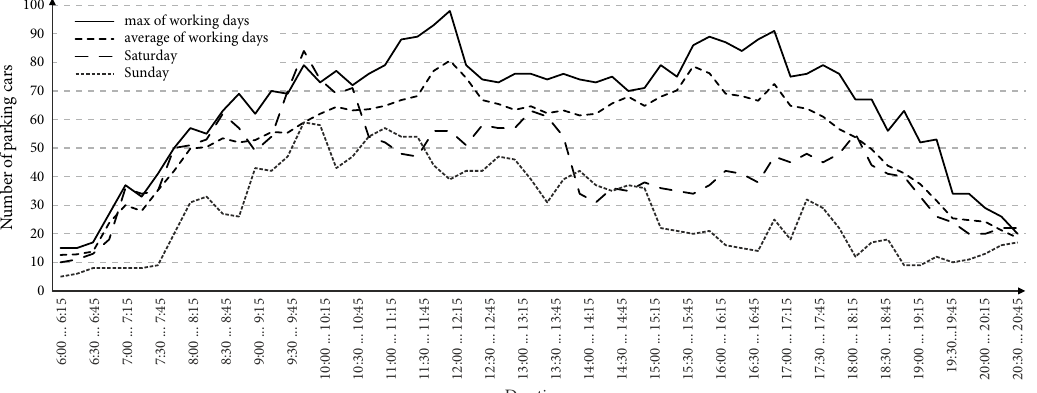
Figure 3. Numbers of occupied parking places during days of week in